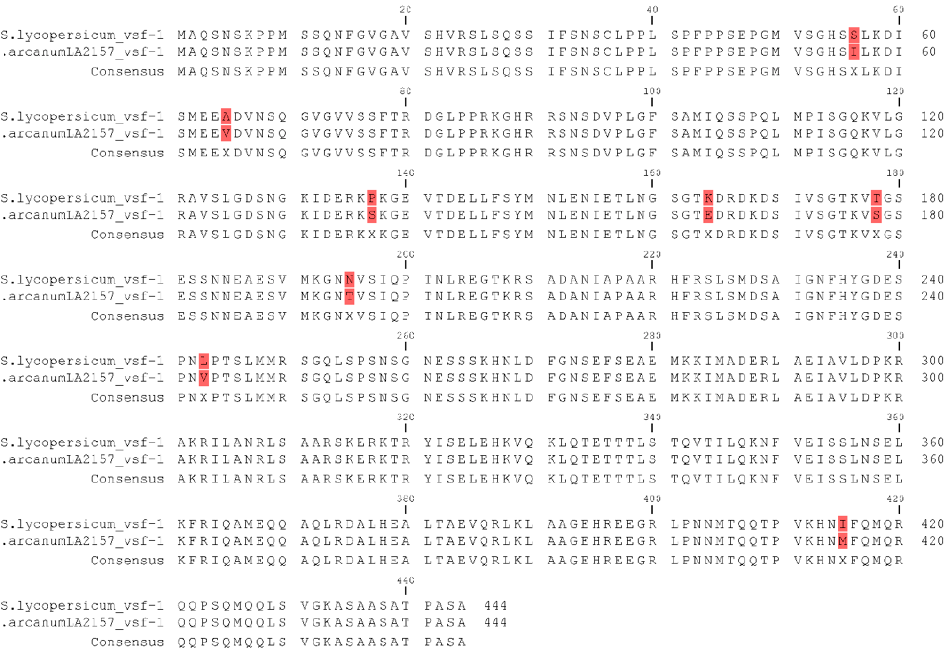
Figure 5. Alignment of the S. lycopersicum vsf-1 protein against the predicted protein of the S. arcanum LA2157 allelic variant. Amino acids in red indicate changes between the two proteins.